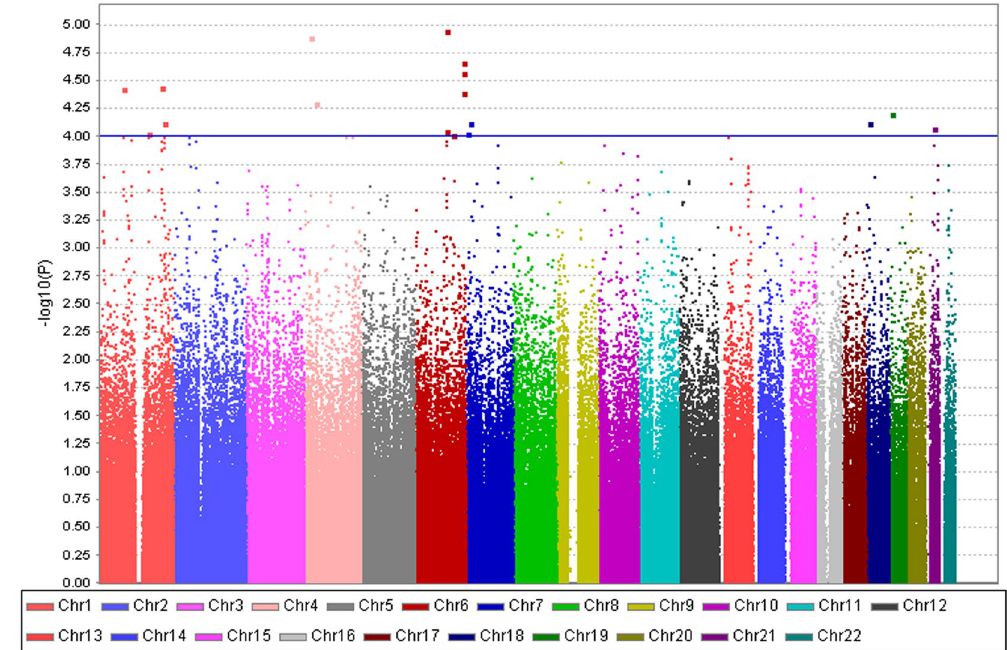
Figure 1. Manhattan plot of a genome-wide association study for the age at onset of schizophrenia performed in 94 probands from multiplex families with the earliest AAO and those with 91 the latest AAO. The x-axis is the chromosomal position, and the y-axis is the significance of the association represented by -log 10 (P-value) derived from multiple logistic regression analyses. The horizontal blue line shows the significance threshold at -log 10 (P-value) > 4 for candidate